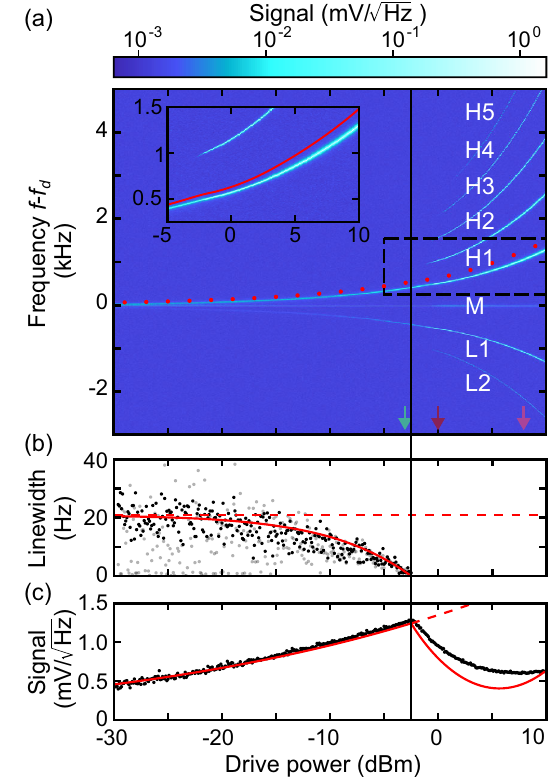
FIG. 2. Frequency comb induced by resonant drive. (a) Power spectra of the mode measured for increasing drive power at ¼ f f 0 . The transition from the regime of two thermal-noise- d induced satellite peaks to the frequency comb consisting of a series of equidistantly spaced, multiple satellite peaks is clearly ¼ − 2 . 5 dBm (black vertical line). The red seen. It occurs at P th dots show the theoretical model for H 1 . The inset shows the magnified region inside the dashed box. Arrows indicate drive power of the line cuts depicted in Fig. 3(a). (b) Extracted linewidth of the two thermal noise-induced satellite peaks H 1 (black) and L 1 (gray) as a function of the drive power. The dashed line represents the prediction based on the theory that disregards driving-induced friction, whereas the solid line includes it [see ¼ f Eqs. (4) and (5)]. (c) Amplitude of forced vibrations at f 0 as d a function of the drive power. The dashed line represents the prediction based on the theory that disregards driving-induced friction, whereas the solid line includes it [see Eqs. (4) and